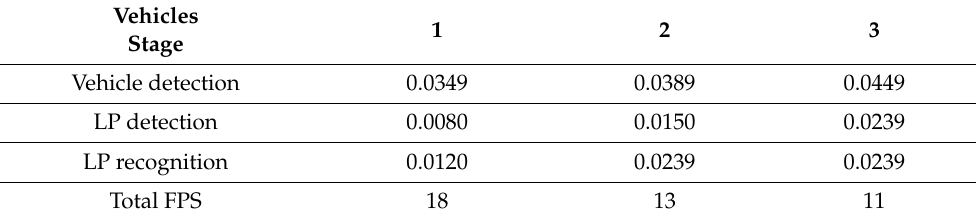
Table 12. The FPS for the full ALPR pipeline, as well as the processing time in seconds for each stage of the pipeline when there are 1, 2, and 3 vehicles in the